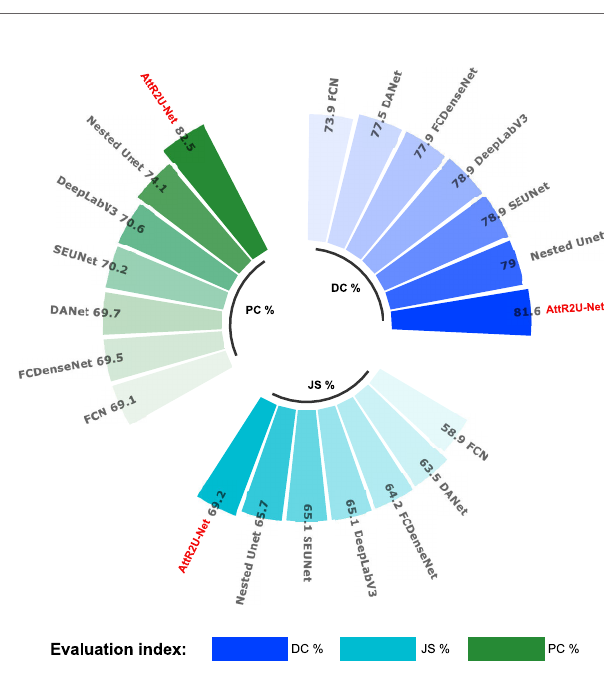
FIGURE 8 | Comparison plots of speci fi c values of 3 key evaluation metrics: include average DSC values, average Jaccard similarity coef fi cient, and average precision obtained from the test on the nasopharyngeal cancer segmentation test set.